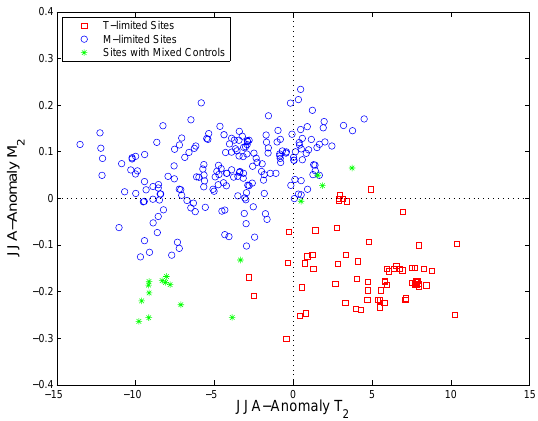
Fig. 8. Plot of estimated M 2 versus estimated T 2 at each site, with both parameters measured as anomalies relative to the local clima- tological mean summer temperature. The color of points denotes the classification of the controls on modeled growth at each site. x = 0 and y = 0 define the mean local summer temperature and soil mois- ture content,